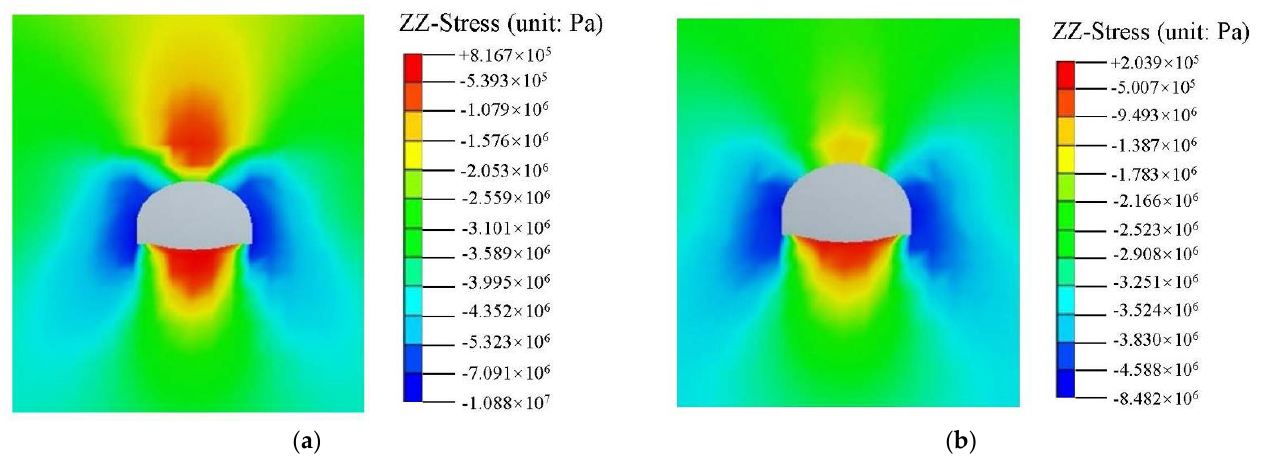
Figure 17. Maps of vertical stress of surrounding rock: ( a ) original design scheme; ( b ) scheme after collapse treatment.